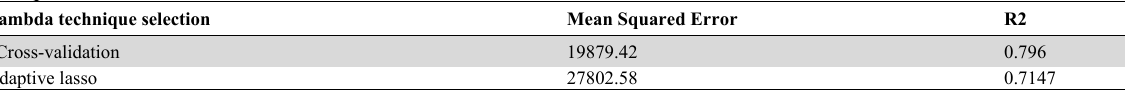
Lasso post-estimation